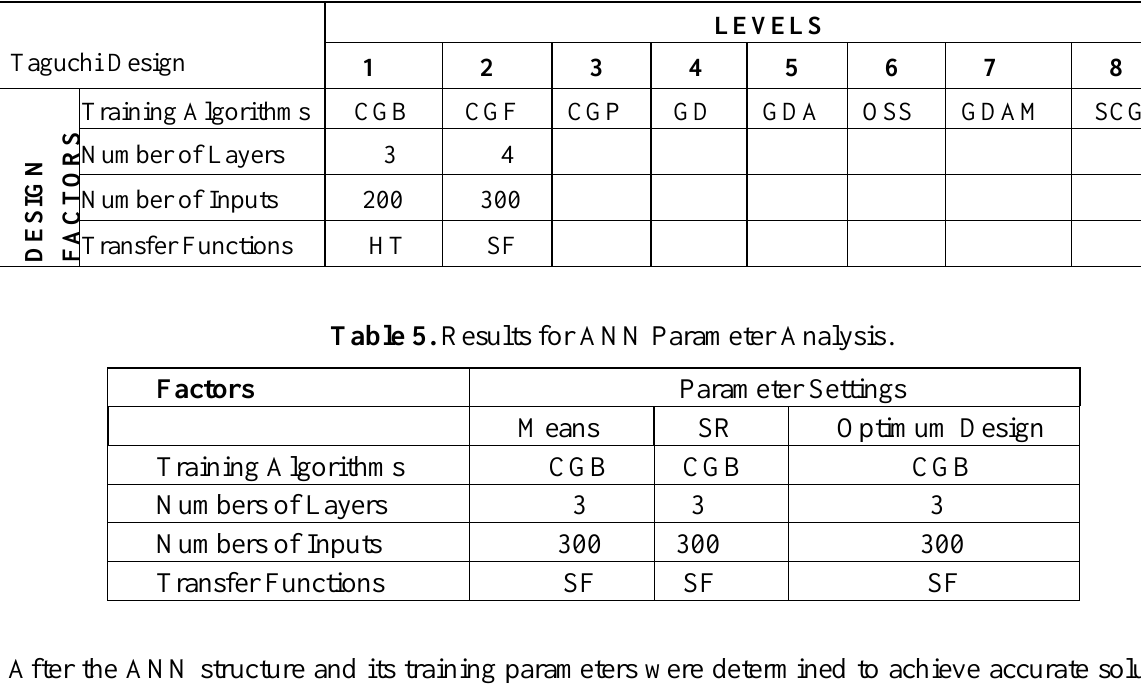
Table 4. Taguchi design factors and factor levels.